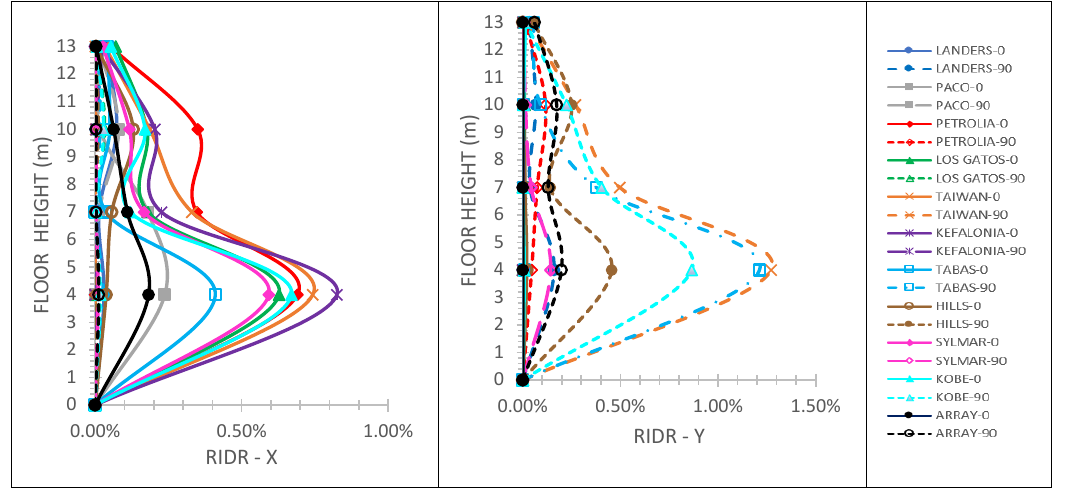
Figure 12. RIDR along X ( left ) and Y ( right ) horizontal directions of the four-story mixed building, considering the